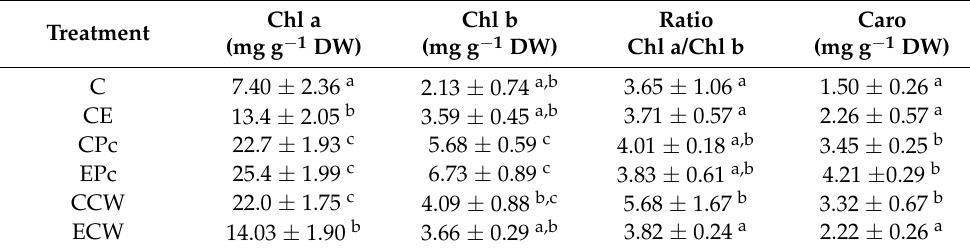
Table 4. Effect of soil treatments on photosynthetic pigments contents. Chl a: chlorophyll a, Chl b: chlorophyll b, Caro: total carotenoids. Treatments: Soil sampled in the Chinampas area was used as control (C); soil contaminated with endosulfan (CE); control soil bioremediated with Penicillium crustosum (CPc); endosulfan-contaminated soil, bioremediated with P. crustosum (EPc); control soil bioremediated with citric waste (CCW); endosulfan-contaminated soil, bioremediated with citric waste (ECW). Values represent the means of five replicas (five individual plants) followed by SD. Different letters in each column indicate significant differences between treatments, according to the Tukey test at the 99% confidence